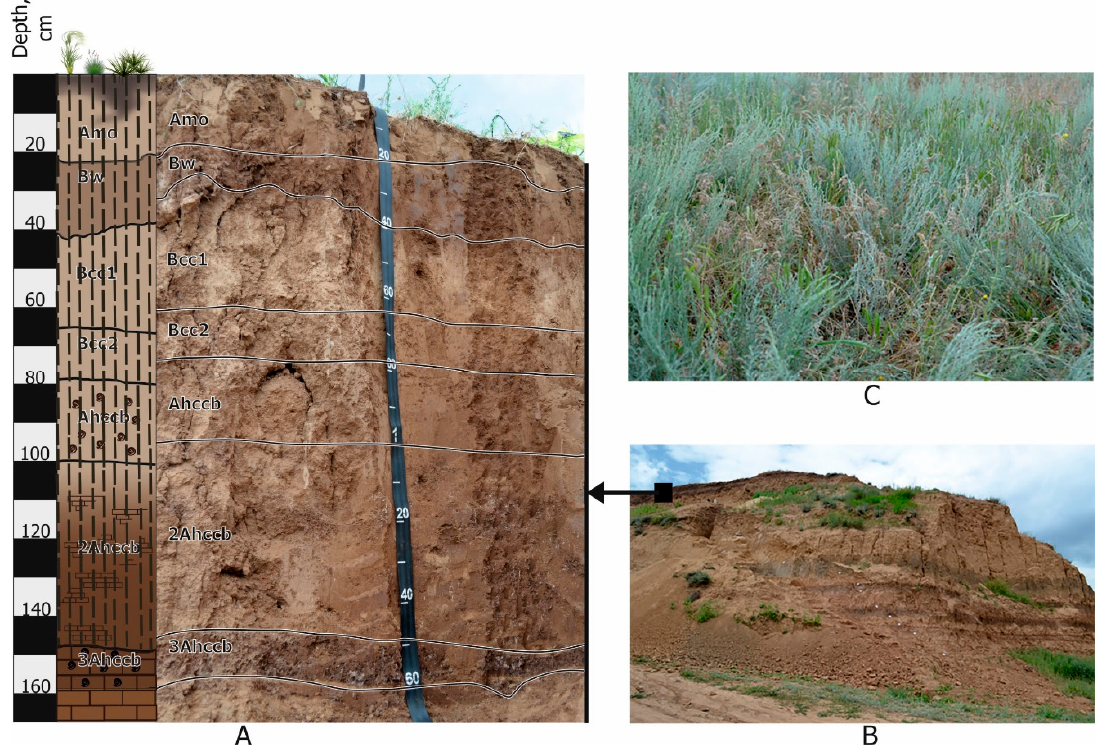
Figure 3. Srednaya Akhtuba study site. ( A ) Calcic Kastanozem; ( B ) General view of the Srednaya Akhtuba outcrop, with the pedosedimentary sequence presented in Figure 2; ( C ) Sagebrush vegetation typical for dry steppe.